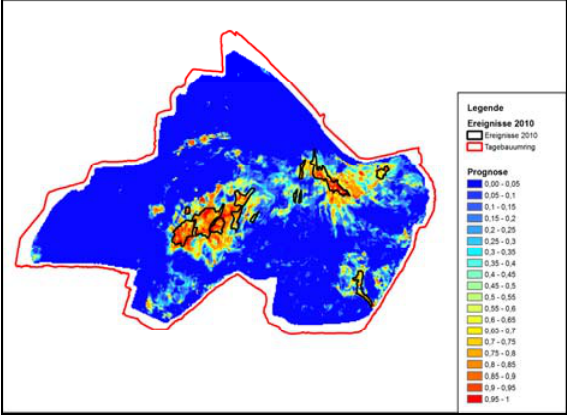
Figure 7. Prediction map based on the known events 2010 For model validation, 50 % of the event related data have been removed from the training scenario. The modelling results of this reduced data set were almost identical with the initial